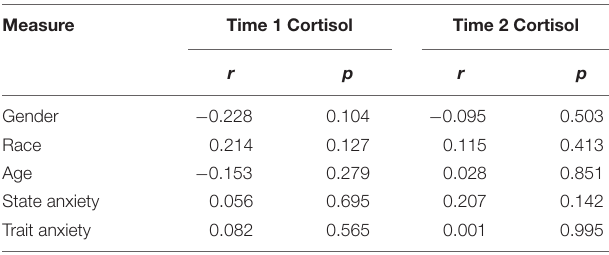
hippocampus, and hypothalamus. The results from this